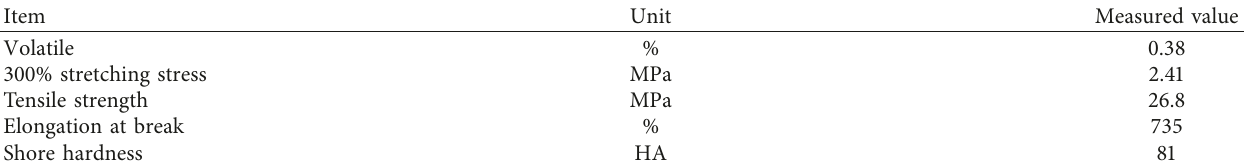
Table 3: Physical characteristics of SBS-T6302.